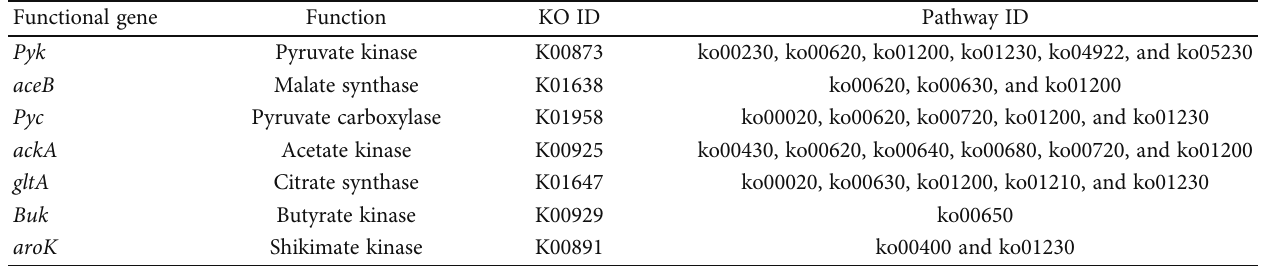
Table 2: Functional genes associated with the secretion of organic acids in solubilizing phosphorus by Bacillus megaterium and their metabolic pathways.